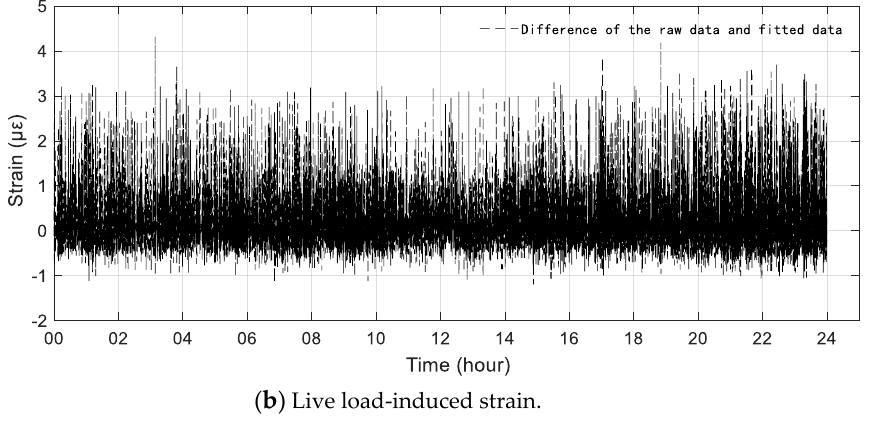
Figure 6. Strain time history of the raw data and the processed data.